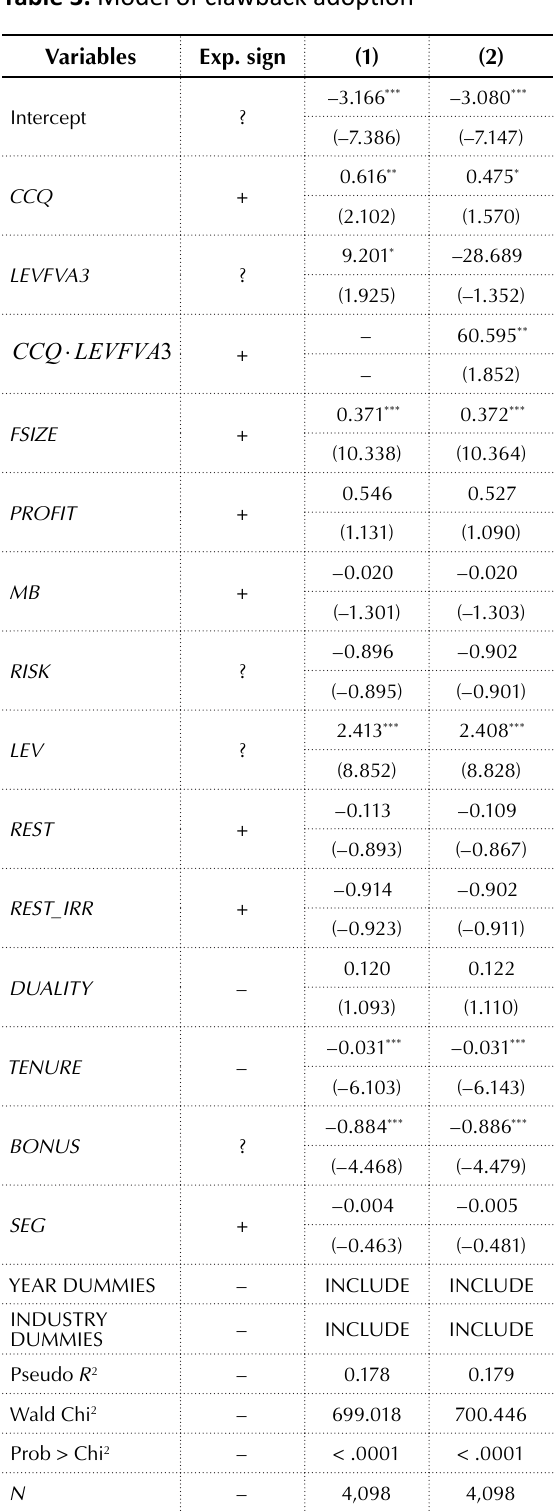
Table 3. Model of clawback